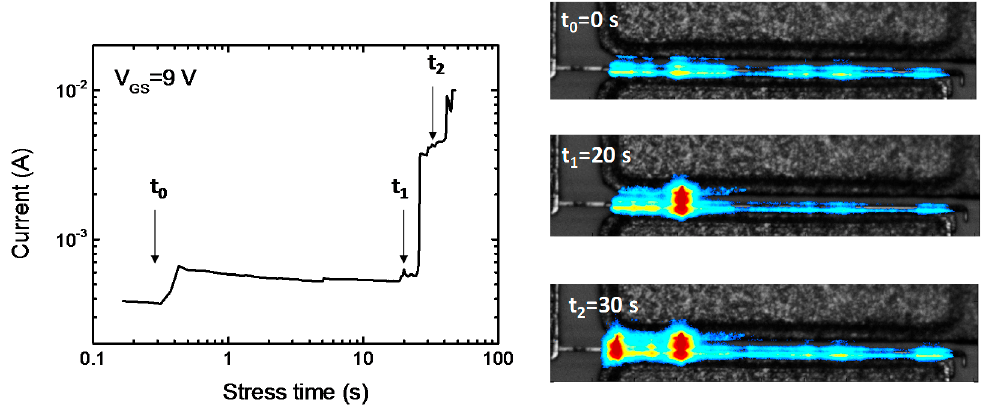
Figure 10. ( Left ) Current variation measured during a constant voltage experiment (V GS = 9 V); ( Right ) False color electroluminescence (EL) pattern reporting the distribution of light emitted by the gate junction during stress, at different time intervals.